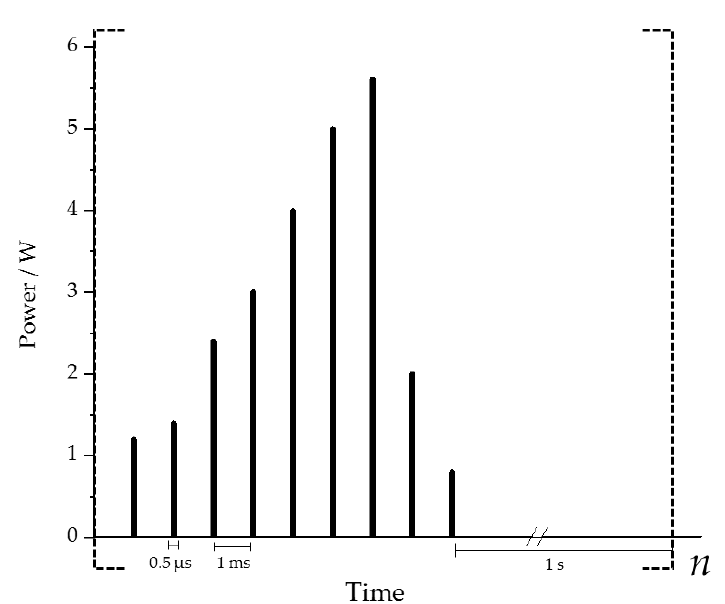
Figure 13. Breathing-like pattern programmed for the NMR pulse waves; n = 300,000 cycles of repetition.